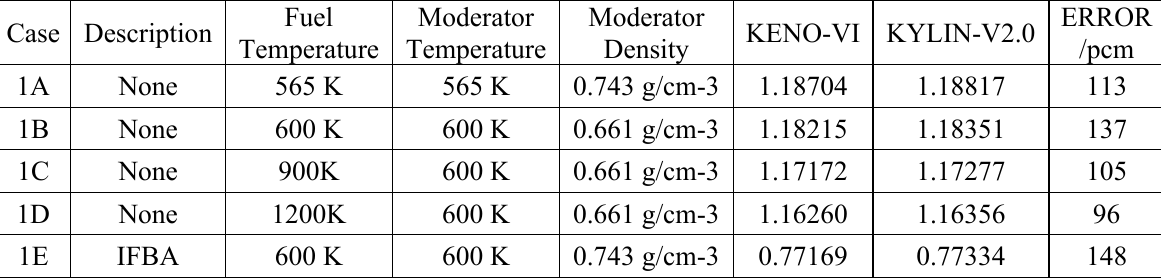
Table II. Comparison of effective multiplication factor for 2D pin-cell